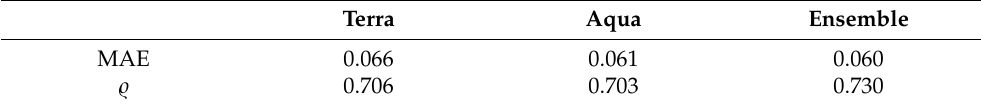
Table 4. Average difference between acquired MODIS (Moderate Resolution Imaging Spectroradiome- ter) and Sentinel-2 NDVI for Tsumagoi. Sentinel-2 NDVI was up-sampled to 250-m for comparison. The date when both Terra and Aqua data were available was extracted for fair comparison.